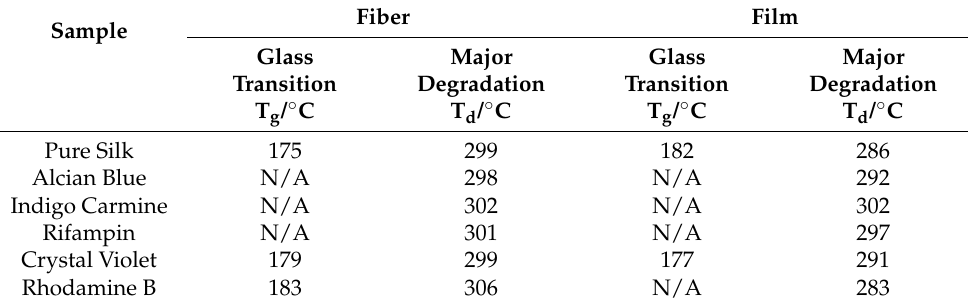
Table 1. Key temperatures from thermal analysis of silk-model drug fibers and films. Values obtained from DSC; temperatures recorded in the middle of the curve for changes in heat flow (middle degradation) or heat capacity.